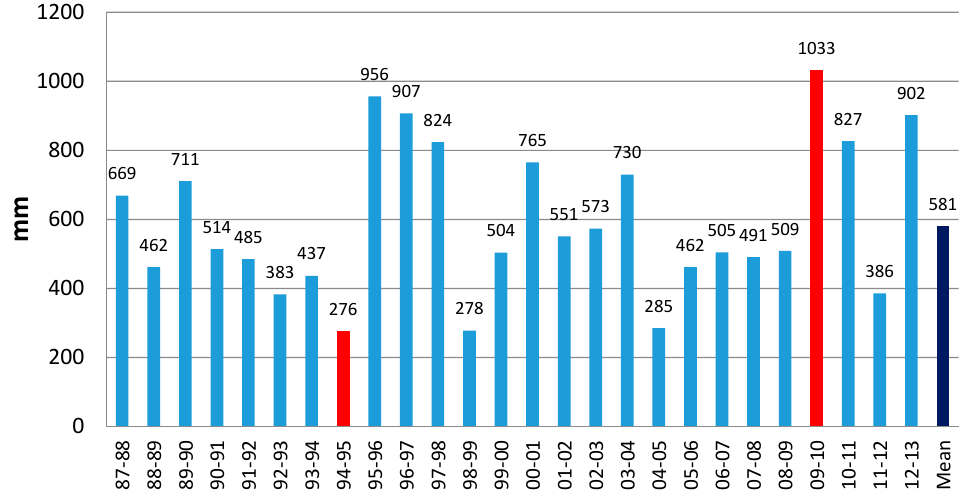
Figure 2. Precipitation in the Guadalquivir River Basin (1987/1988–2012/2013). Red bars show years with maximum and minimum precipitation. (Source: Guadalquivir River Basin Authority).